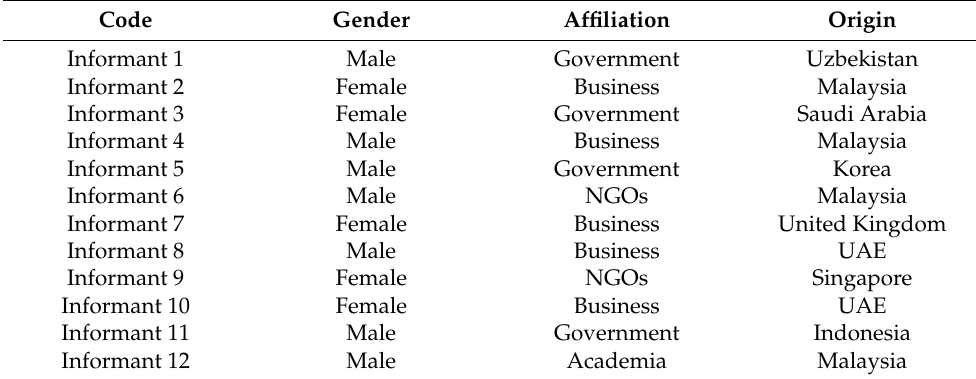
Table 1. Informants